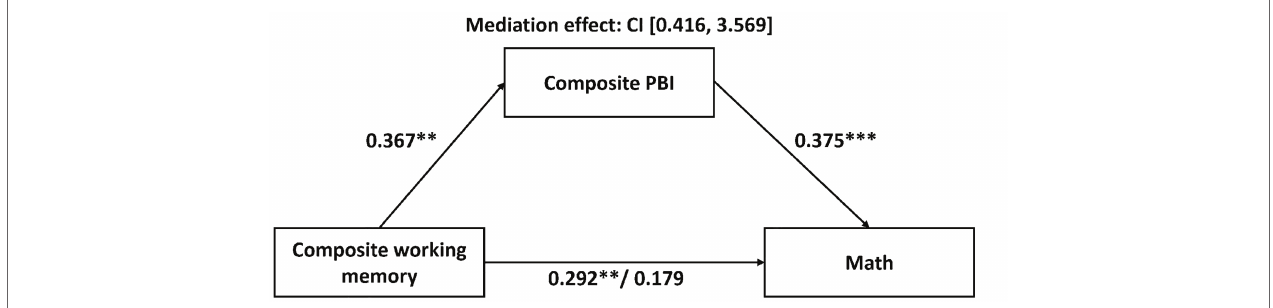
FIGURE 2 | The mediation role of proactive control in the relationship between working memory and math ability. Numbers are standardized beta coefficients, and the value after the forward-slash indicates the standardized beta coefficient after the inclusion of the mediator. *** p < 0.001; ** p <